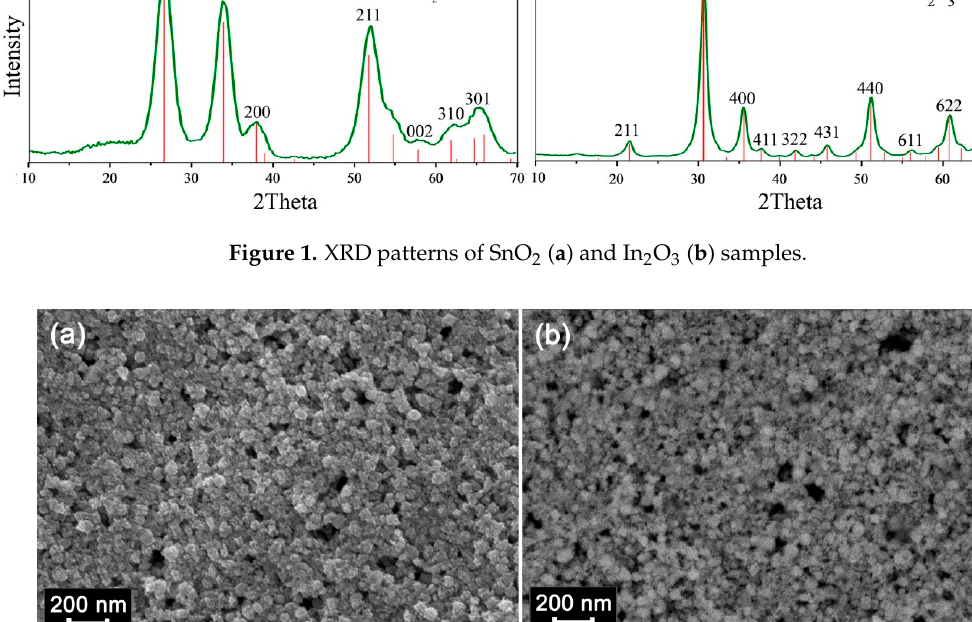
Figure 3. Structure and optical absorption spectrum of Ru-TT complex in a 5 × 10 − 5 М methanol solution.